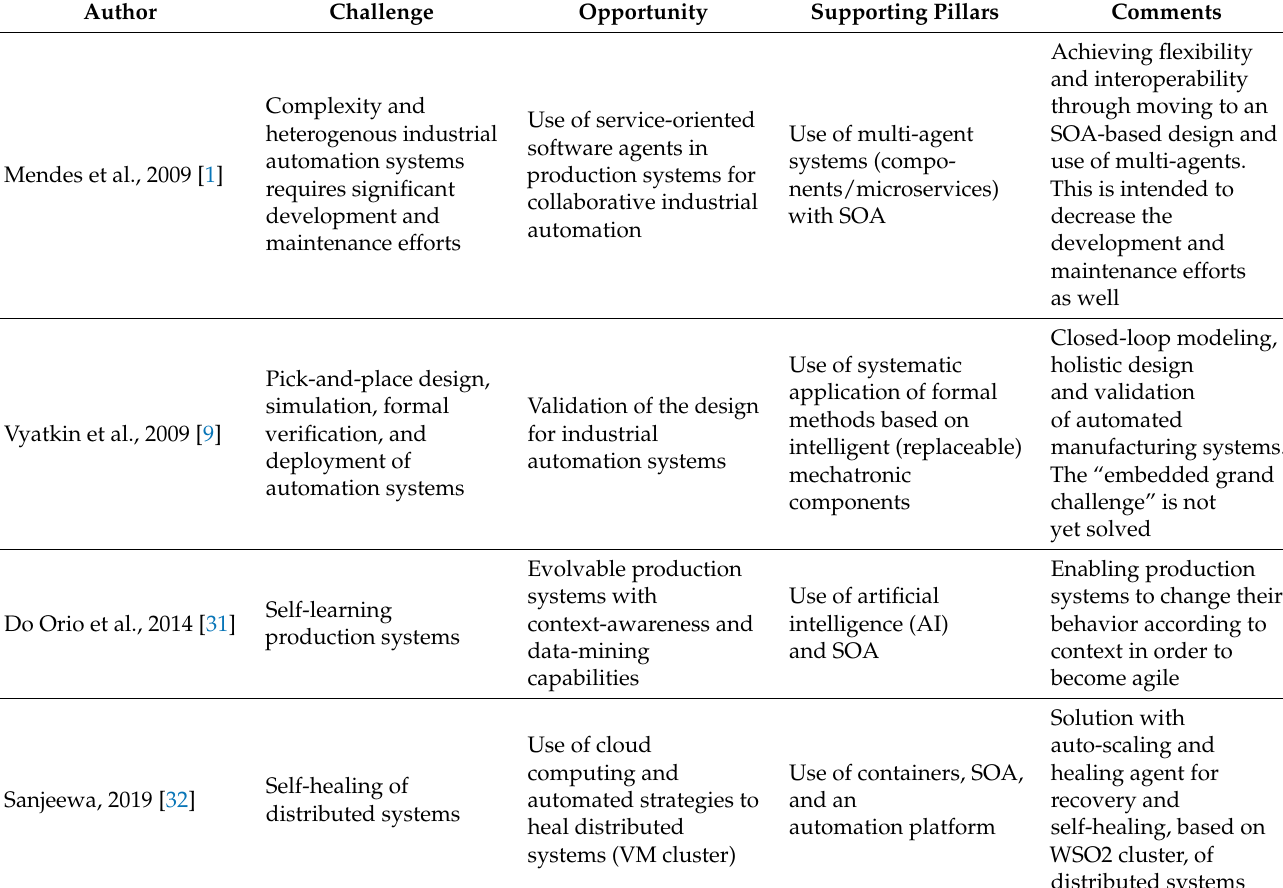
Table 1. Summary of results from the literature